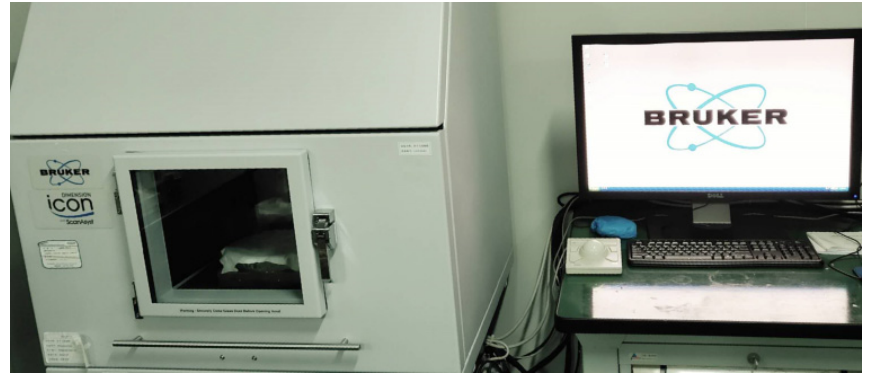
Figure 6. Atomic force microscope (Bruker Dimension Icon). The results showed that the roughness values were small after processing (Figure 7).